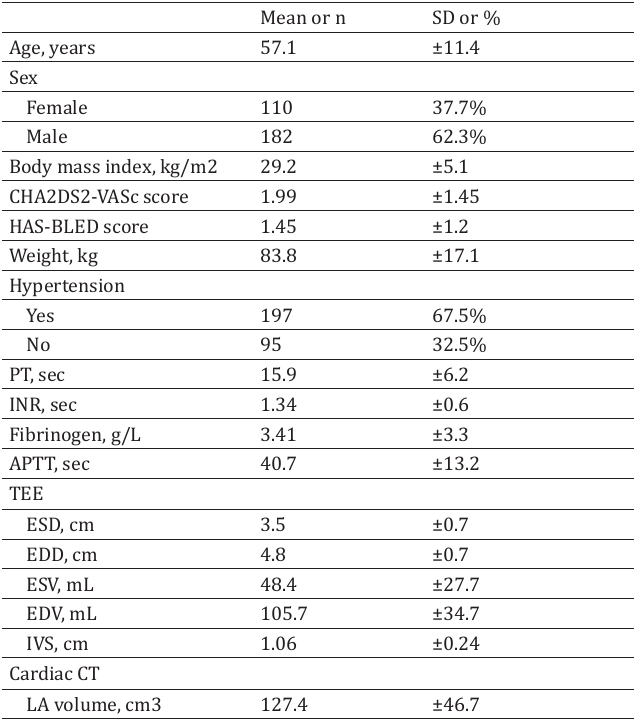
Demographic and medical characteristics of the patients (N=292)